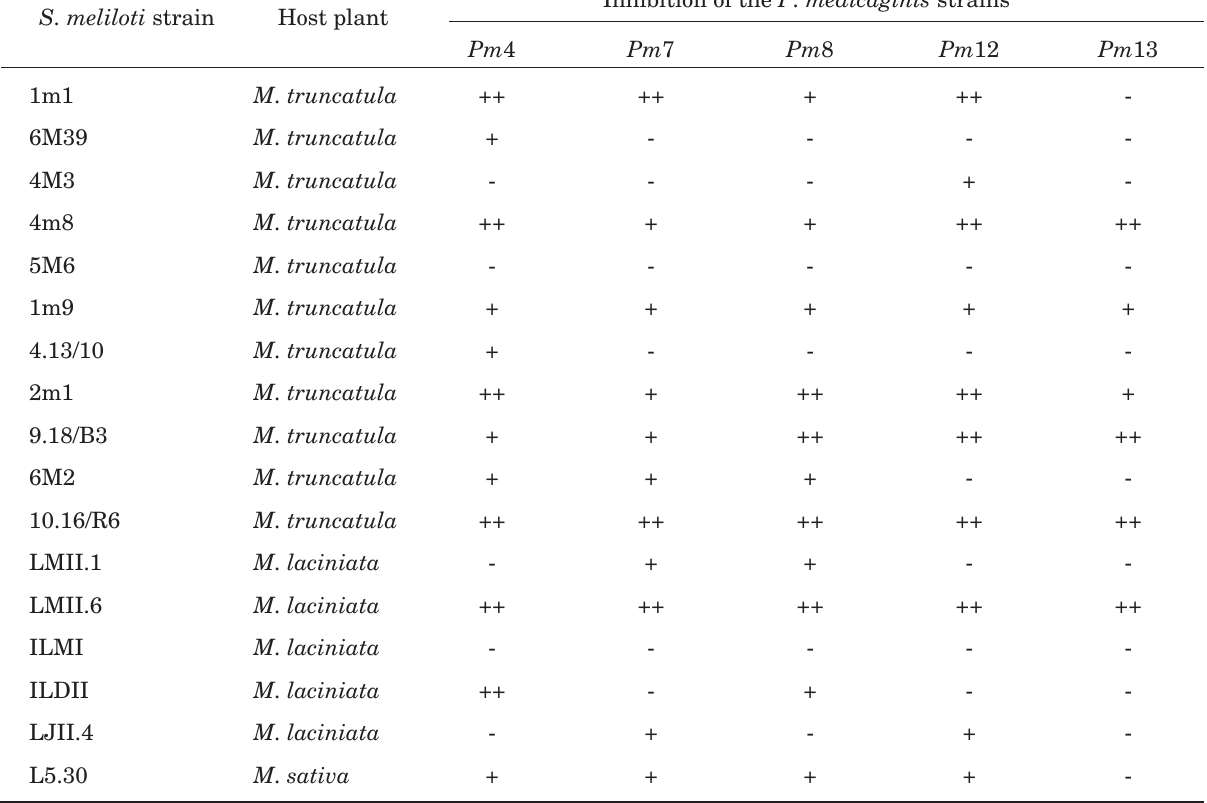
Table 1. In vitro inhibition of fi ve strains of Phoma medicaginis 4 days after the application of Sinorhizobium meliloti strains.